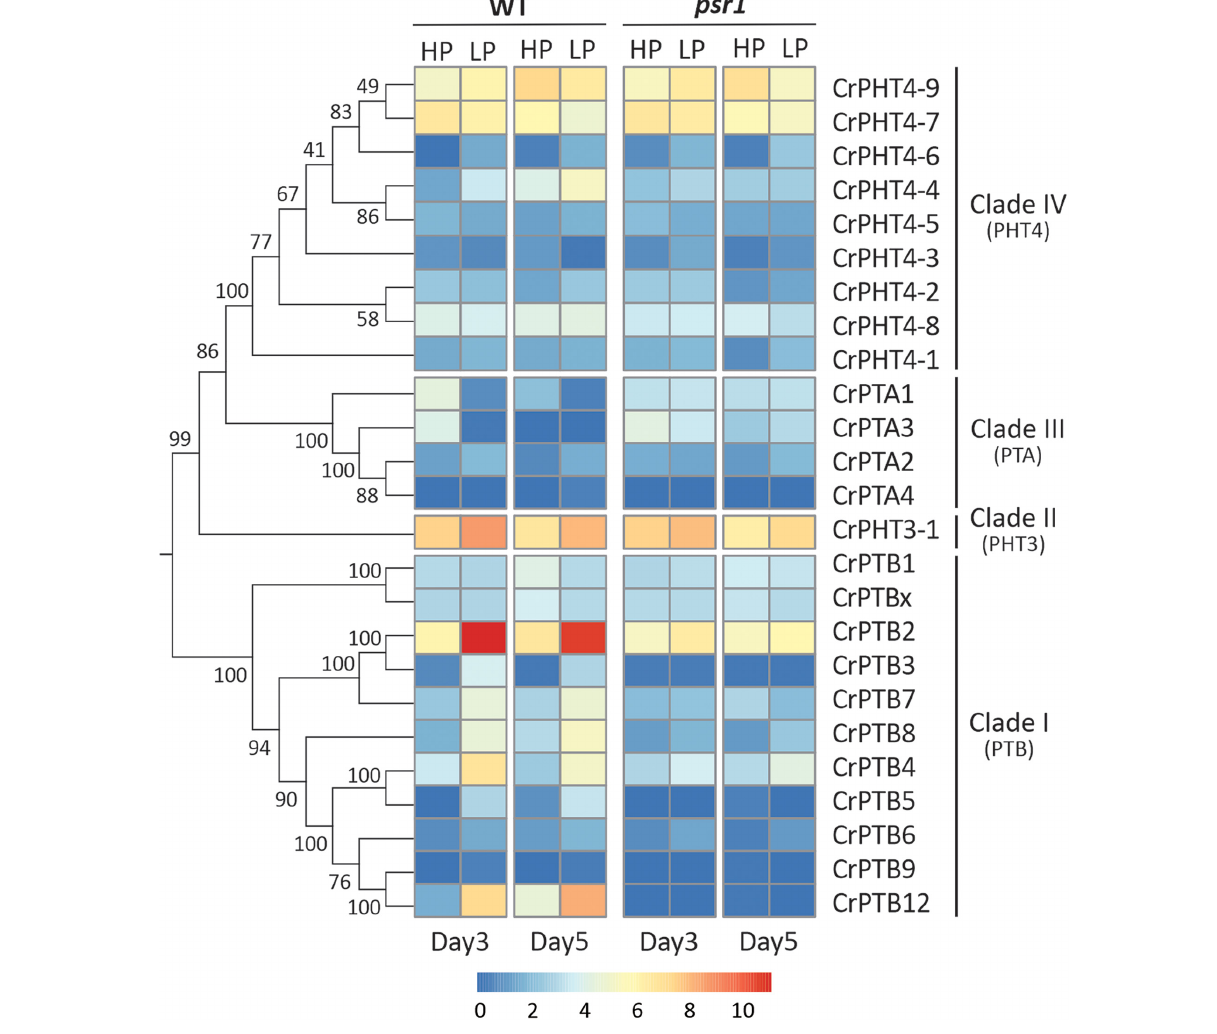
FIGURE 3 | Expression profiles of Chlamydomonas PHT genes under phosphate-replete and starvation conditions. The phylogenetic tree of PHT proteins, showing in the left panel, was constructed by the neighbor-joining method with 1000 bootstrap replications using MEGA 7.0 software. Bootstrap values were shown on the branches. Heat map showing the expression of phosphate transporter genes under high-P (HP) and low-P (LP) conditions in day 3 and day 5 which display change in expression relative to WT HP conditions or psr1 HP. Each value corresponds to log2 of normalized counts. Day 3 and day 5 mean equivalence to the onset of P starvation and 48 h after the onset of P starvation,